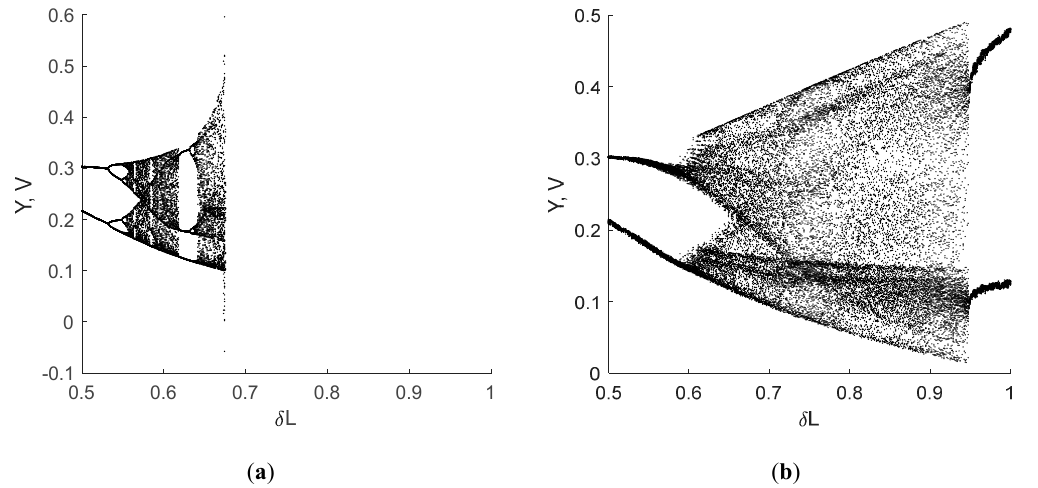
Figure 14. Bifurcation diagrams of the Case N system for V n = 1.5V: ( a ) original ODE, where one can observe the loss of stability when δ L > 0.68; ( b ) analog circuit/equation with saturation.